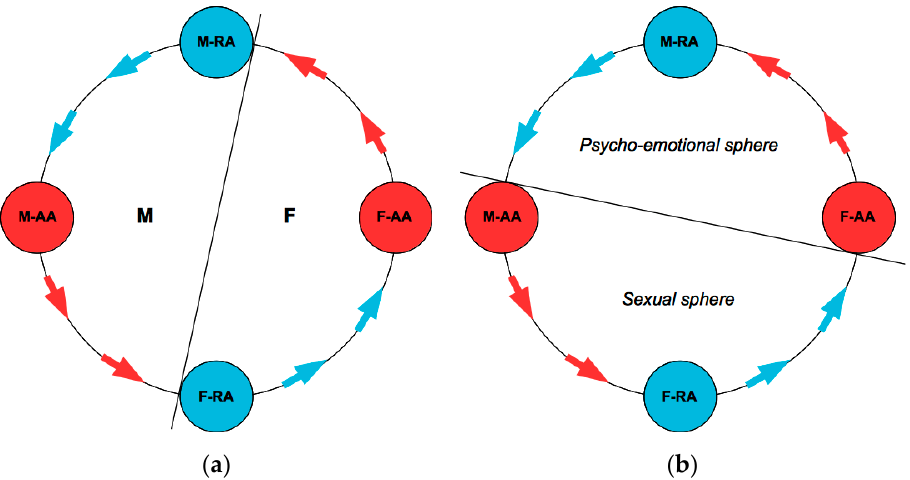
Figure 1. Tie-Up Cycle (TU-C) diagram and its possible partitions into hemicycles: ( a ) According to sex (male vs. female); ( b ) according to dimension (psycho-emotional vs. sexual). Red denotes Active Areas (AAs) and their provision of direct rewards, blue denotes Receptive Areas (Ras) and their provision of indirect rewards. The arrows show the natural direction of the cycle.